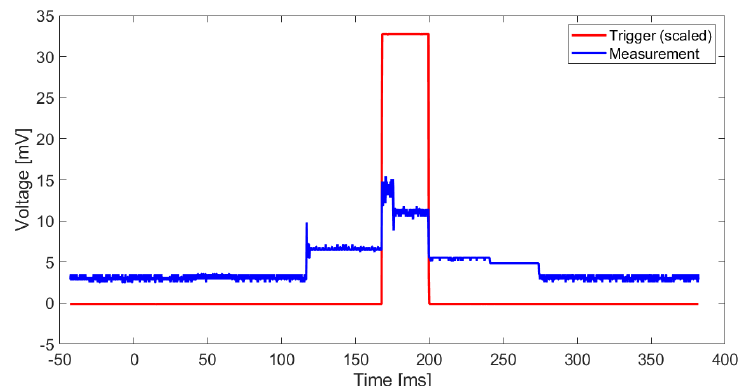
Figure 9. Measured voltage between TP5 and TP6 to measure the power consumption of GAP8 while classifying 1 s of EEG data (blue), trigger signal indicating the start and the end of the processing of 1 s of EEG data.